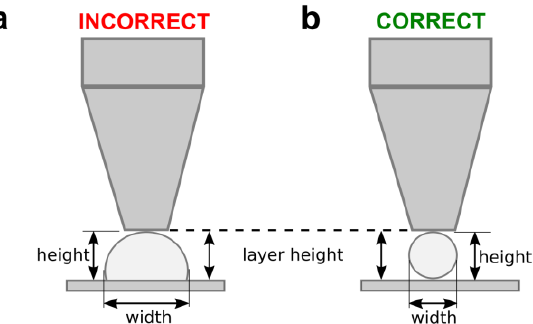
Figure 2. The scheme of the layer height adjustment used to evaluate the influence of the carriage speed on the PCL deposition. A slow speed produces wider and flattened filaments of PCL ( a ). The correct carriage speed should generate homogenous filaments of widths similar to that of the nozzle diameter ( b ).